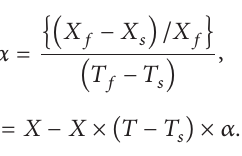
Table 1, 27 points (urban park: 9, low-rise apartment area: